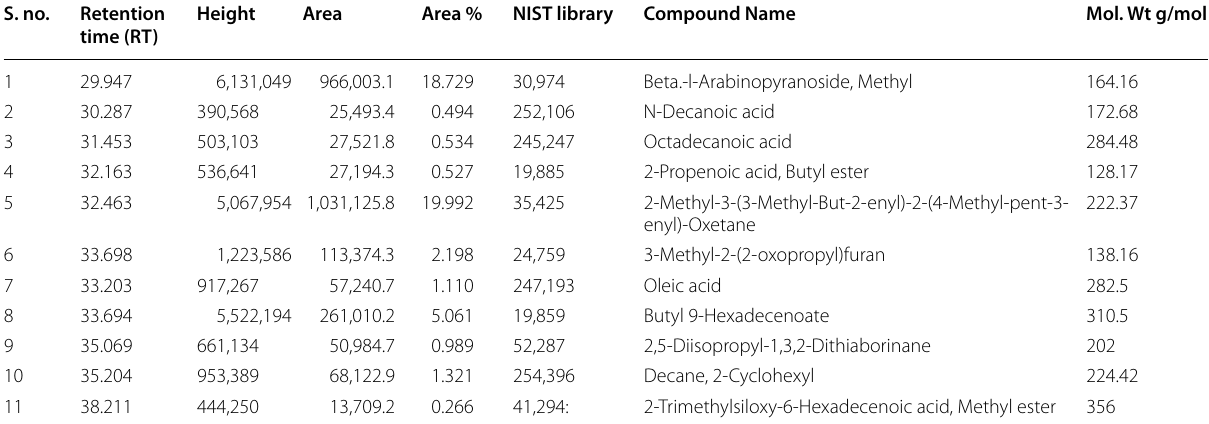
Table 5 GCMS library search for E. indicum (Methanol extract) S.